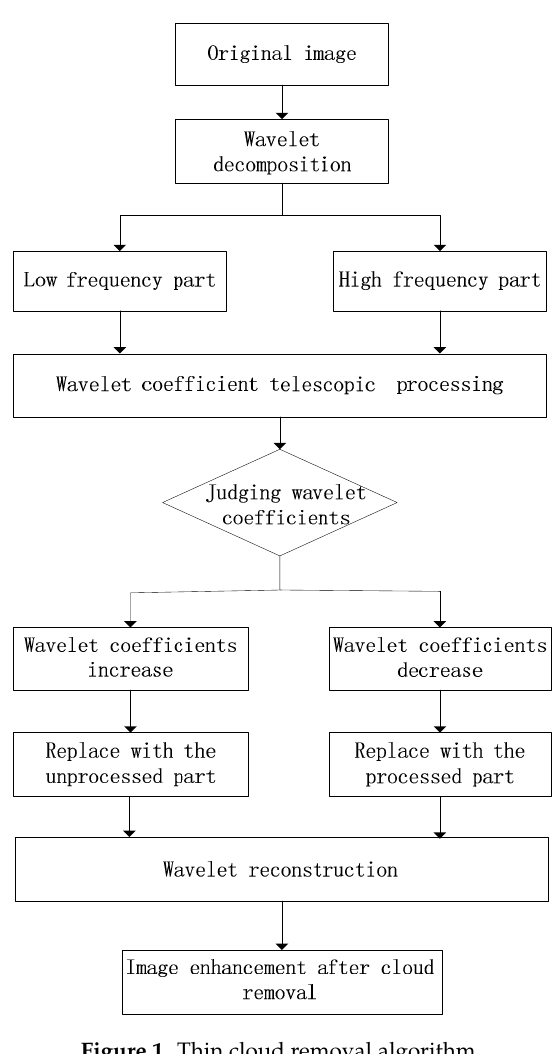
Figure 1. Thin cloud removal algorithm.